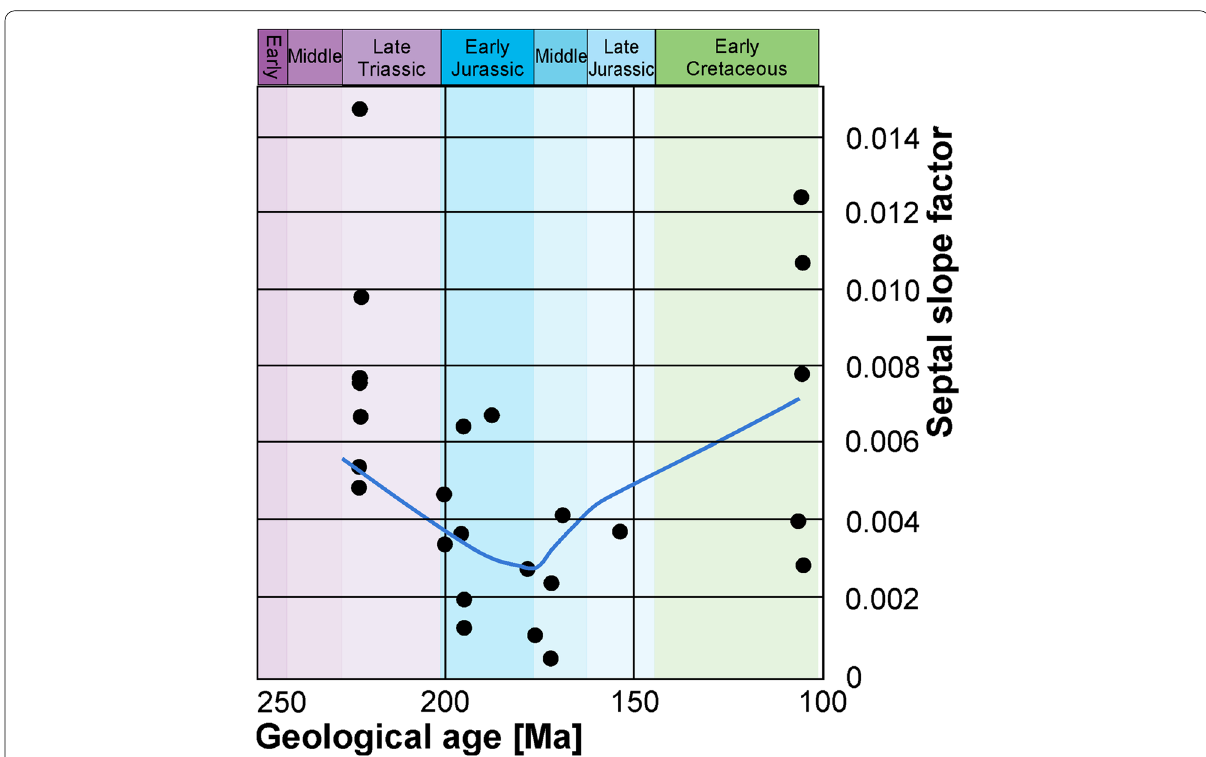
Fig. 12 Septal thickness septal slope factor data: Mann–Kendall test, septal slope factor as a function of time. The lowest point is Arietites sp. The graph shows a downward trend from the Triassic to the Jurassic with the highest peak in the Late Triassic and an increase in the